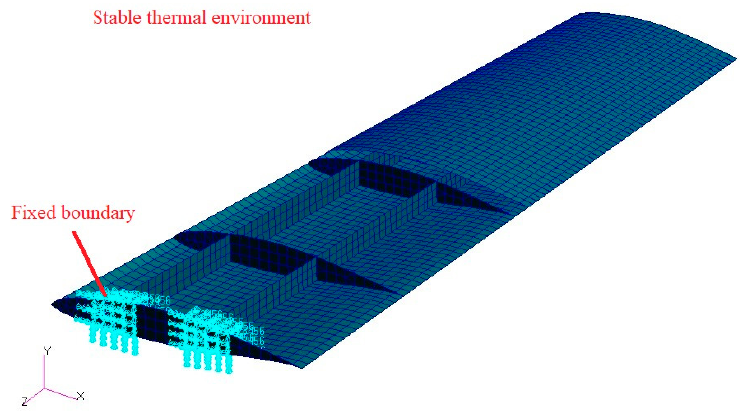
Figure 7. The finite element model of wing structure.